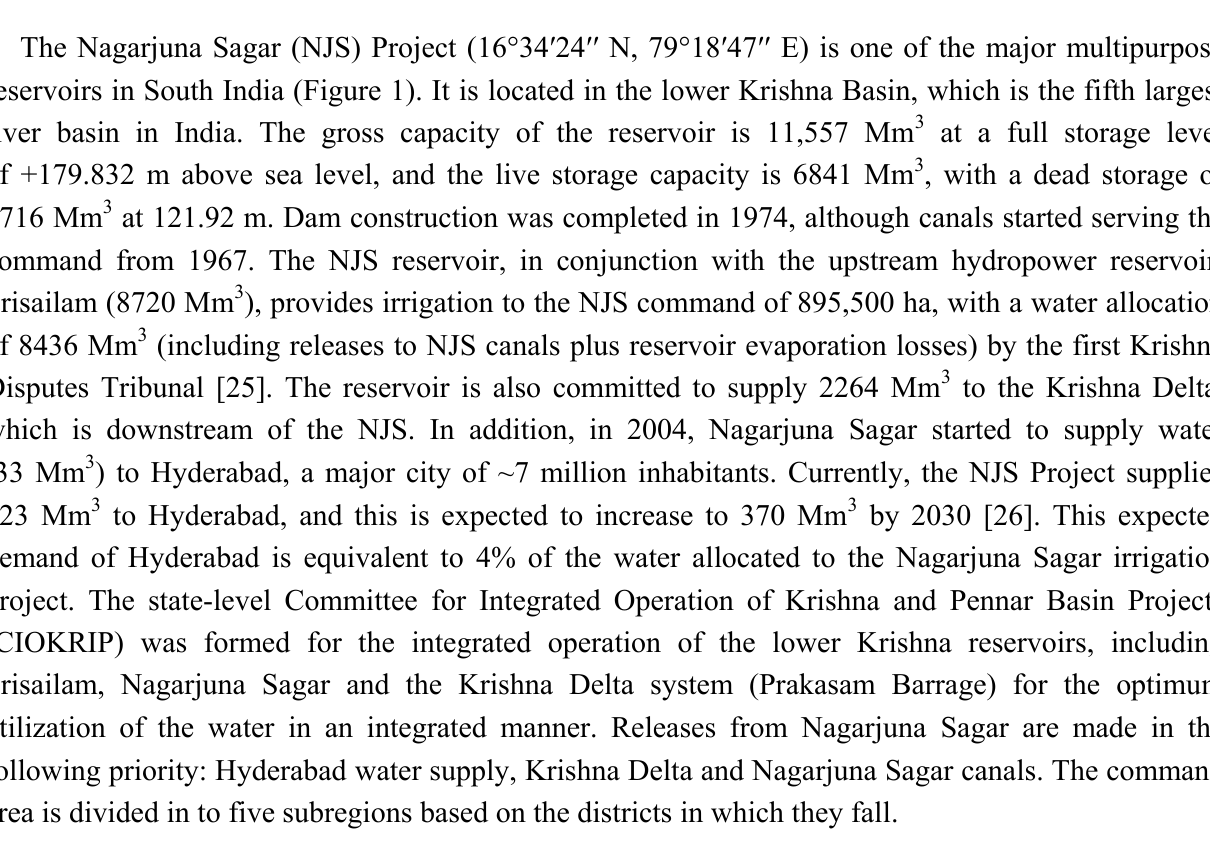
Figure 1. Location map of the Nagarjuna Sagar (NS) command area in southern India. In the main panel, the clear polygons and italicized labels are the district boundaries with canal distributaries. The lower right inset shows the lowest administrative